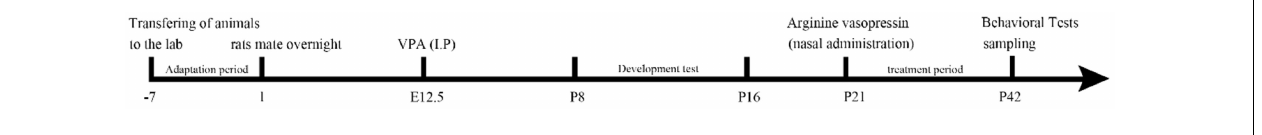
FIGURE 1 | Schematic representation of the experimental